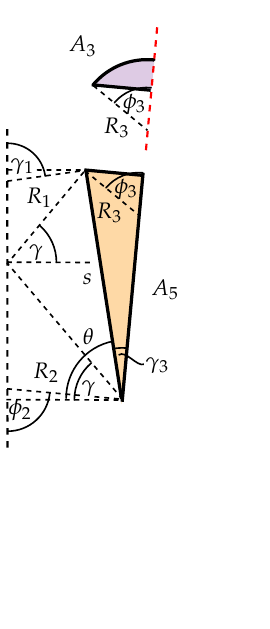
Figure 15. Partial cross-sectional areas A 1 , A 2 , A 3 , A 4 , and A 5 of a segment of the curved woven mattress. The numerical results for different values of x are given in Table 4. These values of x include the curvature of the woven mattress, which is defined as